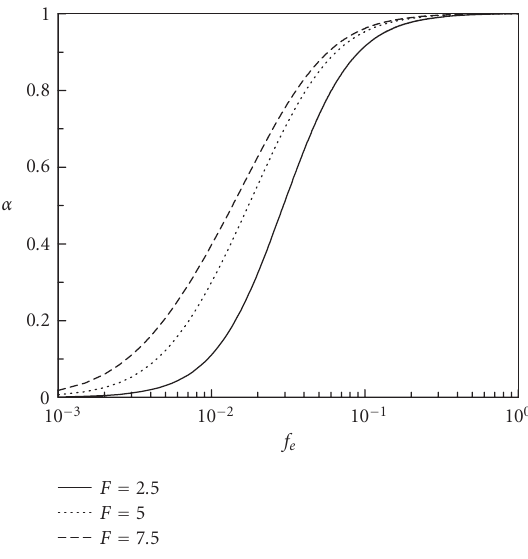
Figure 4.4. Spatial growth rate α = k i /k min